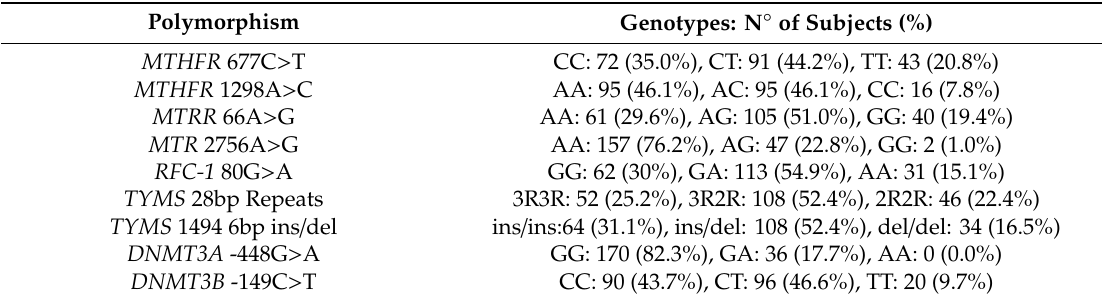
Table 2. Distribution of genotypes in the study